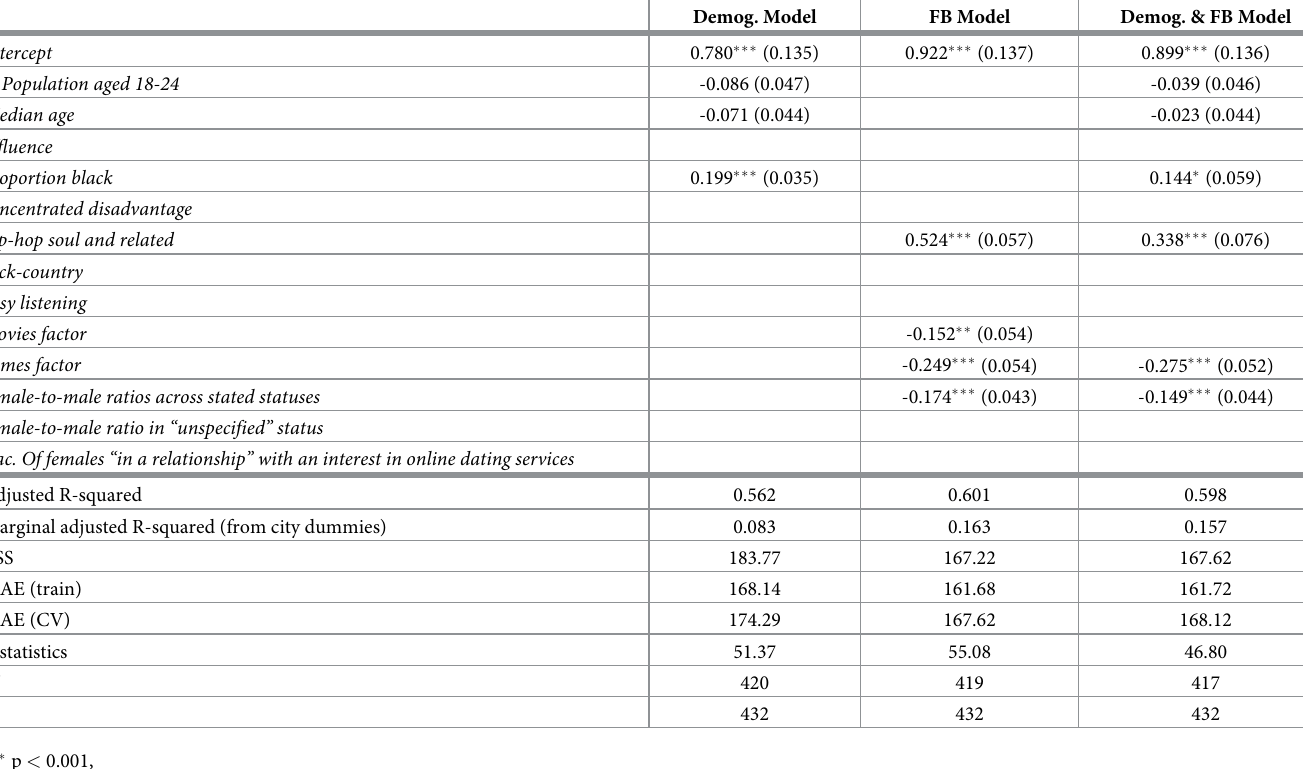
Table 4. Parameter estimates and fit statistics for regression models predicting burglary